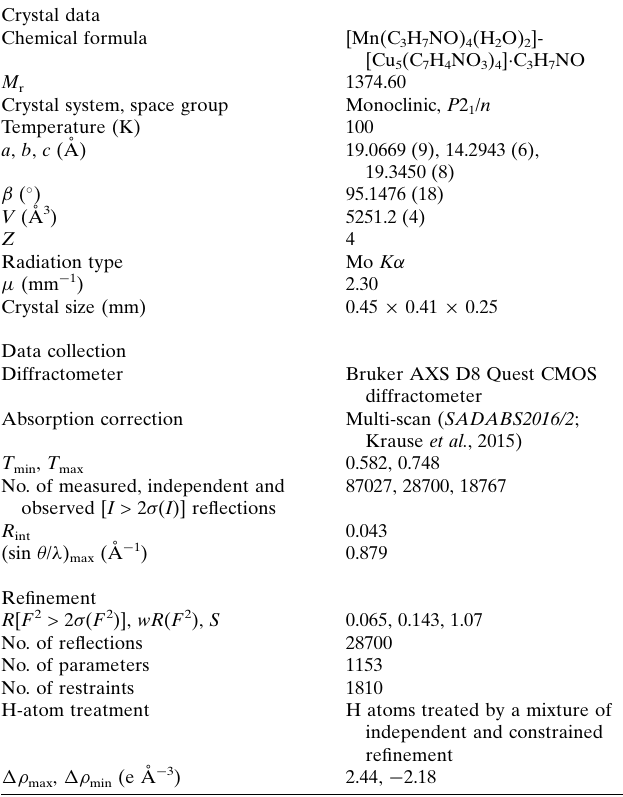
Crystal data Chemical